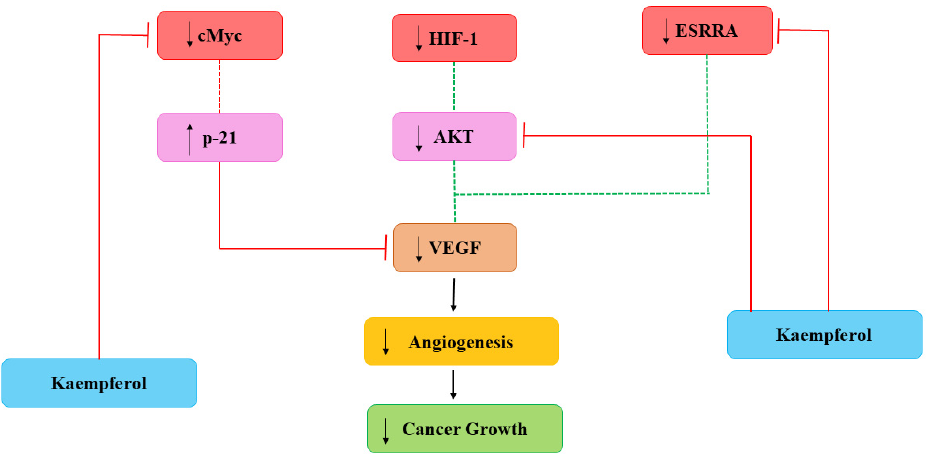
Figure 3. Kaempferol effects on Angiogenesis. HIF-1: hypoxia inducible factor-1; VEGF: vascular endothelial growth factor; ESRRA: estrogen related receptor alpha. Dotted lines signify earlier processes that have decreased due to Kmp [23].